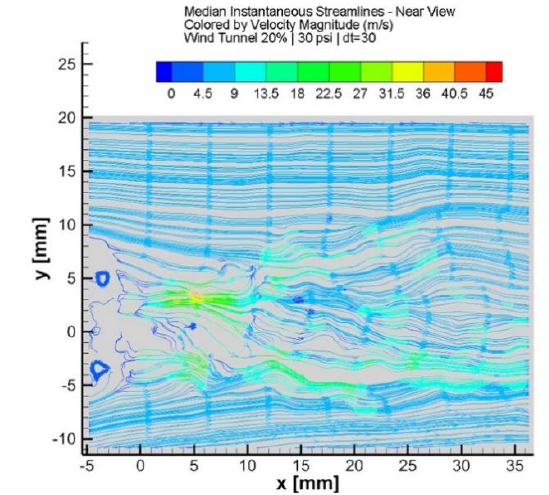
Figure 6. Annular structure at vortex tube exit region instant streamlines (30 psi, 20% freestream). also for establishing a frame of reference for the flow that will be interacting with the airfoil later. A